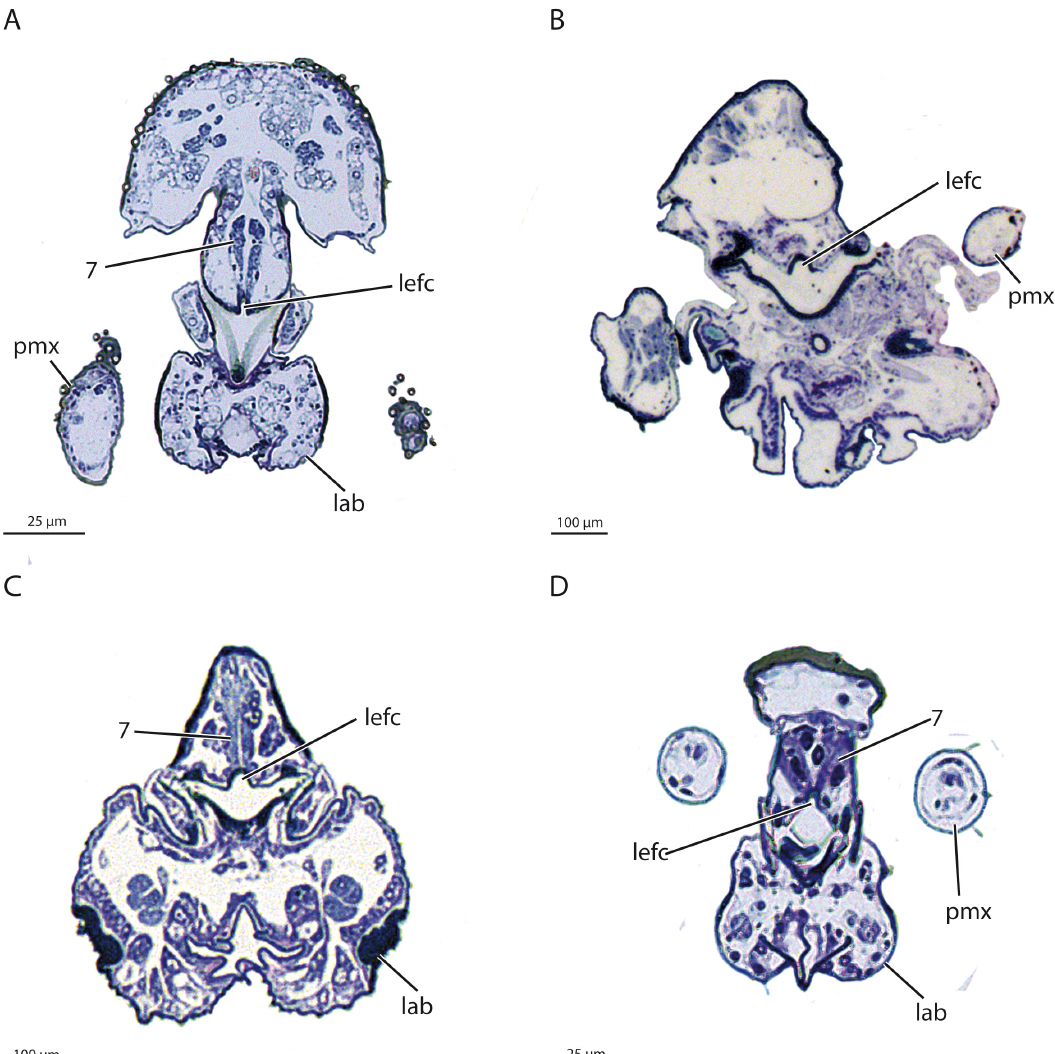
Figure 9 . Cross-sections. A, Psychoda alternata (Psychodidae). B, Tipula paludosa (Tipulidae). C, Trichocera saltator (Trichoceridae). D, Corethrella appendiculata (Corethrellidae). Abbreviations: lab, labella; lefc, labroepipharyngeal food channel; pmx, maxillary palp; 7, M.